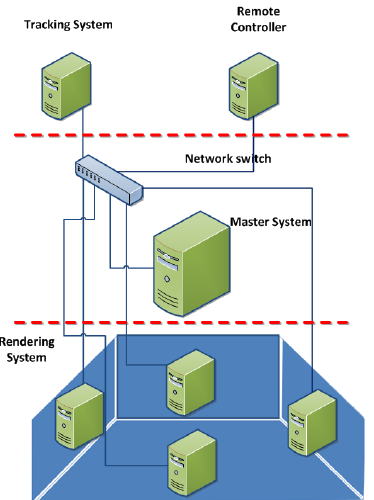
Figure 2: The physical diagram of immersive visualization. The visualization system is compose of three layers with different re- sponsibility. First layer comprises motion capture (tracking) sys- tem and control capturing. A master PC in the middle layer for the synchronization, and finally four systems for rendering for each wall of the CAVE. All systems are connected together via an ethernet network.